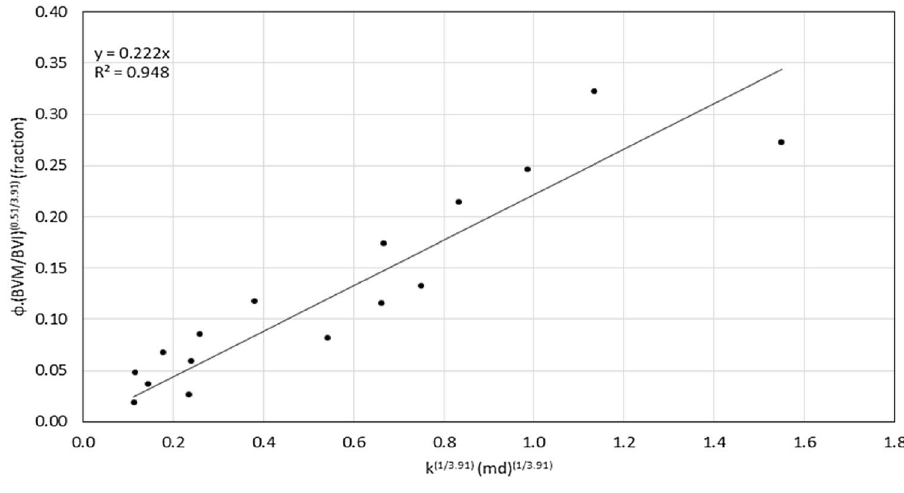
Fig. 10 C determination in modified TC model (design model, m = 3.91, n = 0.51)